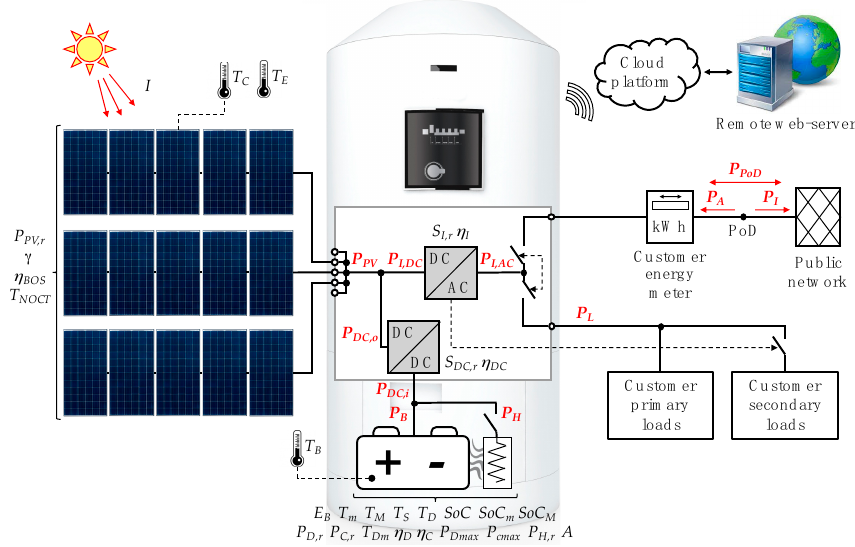
Figure 1. Electrical scheme depicting the represented model. Table 2. List of variables and parameters, with indications of the mathematical expressions in which they first appear.